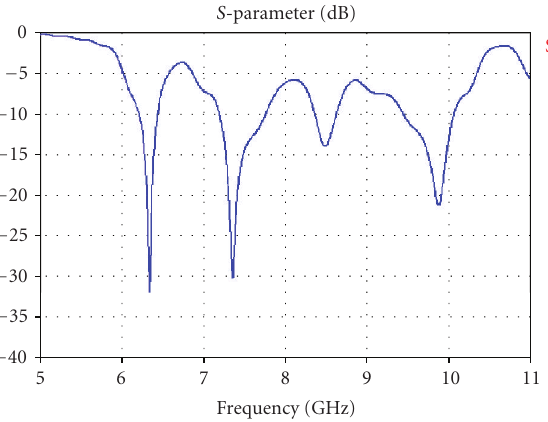
Figure 6: Simulated return loss of multisection LWA Type I.